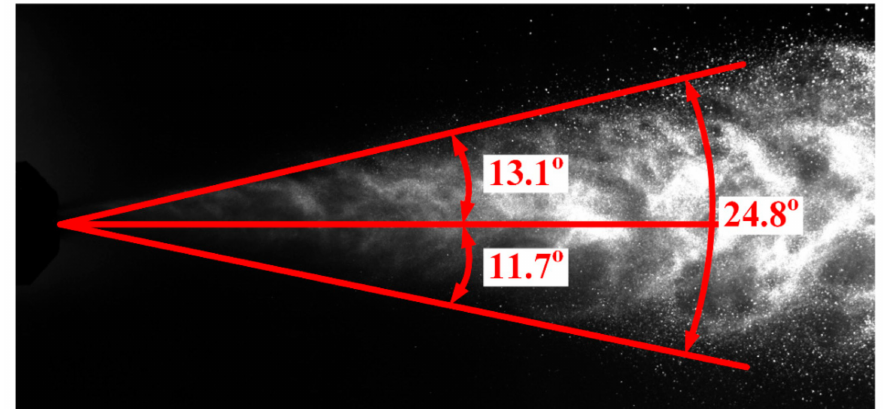
Figure 11. The jet spraying angle of liquid hydrocarbons.